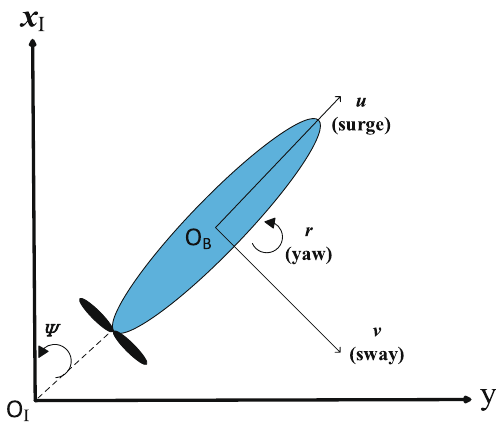
Fig. 2 AUV motions represented by the frames { I } and { B } in the horizontal